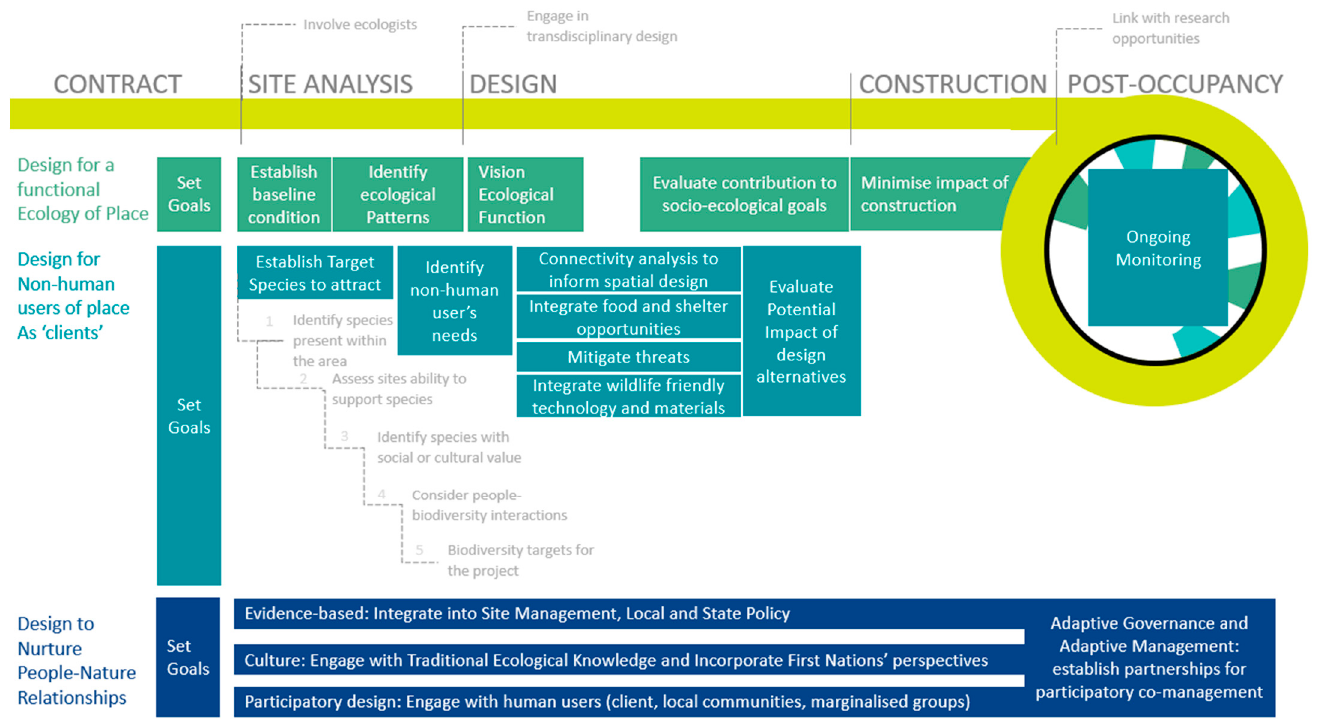
Figure 5. Synthesis of the Biodiversity Inclusive Design Process. The yellow-green loop at the top represents a typical design process with five key stages: contract, site analysis, design, construction, and post-occupancy design phases. The circle at the final stage is used to represent the iterative and ongoing nature of design processes; the post-occupancy stage is under constant evaluation. The three categories of the y -axis represent the three core dimensions of action: design for a functional ecology of place, design for non-human users of place and design to nurture people-nature relationships. The coloured boxes stand for the recurrent activities that design teams should complete at different stages of the design process by the analysed frameworks. The colour of the boxes represents the dimension of action to which they are aligned. The green colour represents actions that will help designers deliver a functional ecology of place; the turquoise colour represents actions that will help design for non-human users of place; and the deep blue colour represents actions and partnerships that should be developed to nurture people-nature relationships. Lastly, in light grey text we find opportunities for collaboration across whole phases of the design process, or specifically as sub-steps to identify target species for the project.